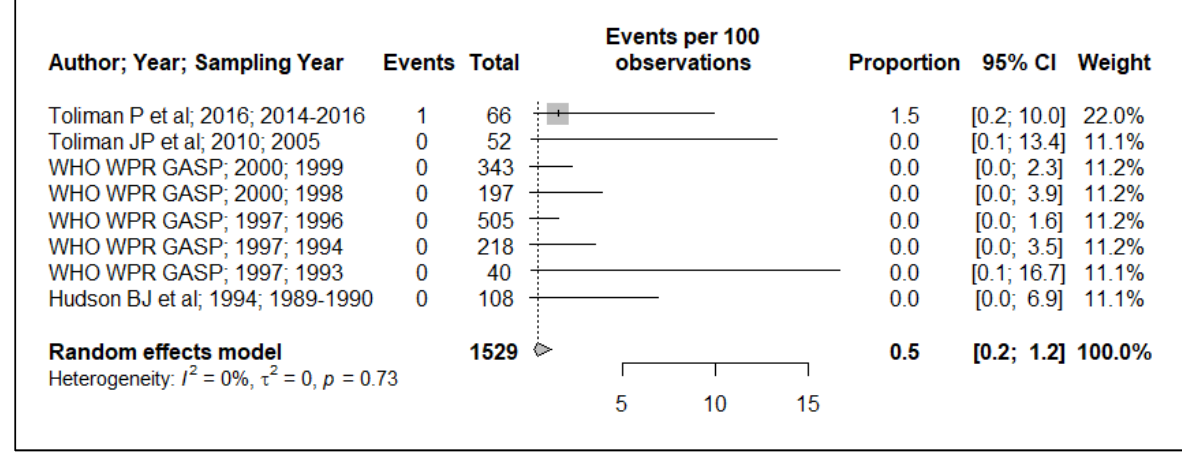
Figure 7. Cephalosporin resistance prevalence